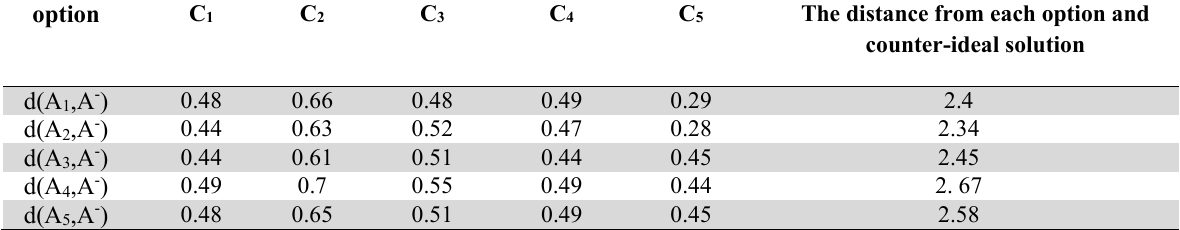
The distance from each option and counter-ideal solution option 1 C 2 C 5 C